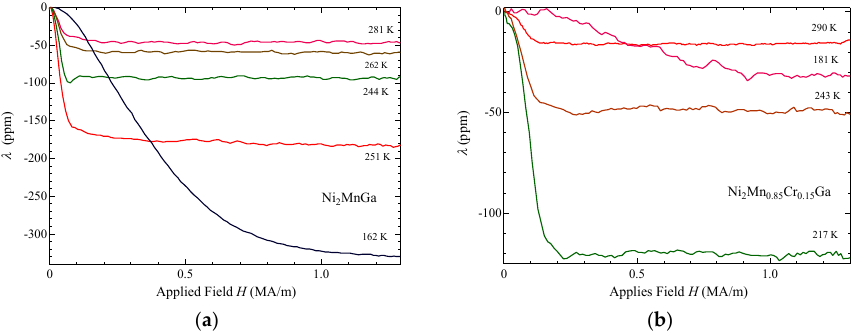
Figure 5. The magnetostriction λ for the ( a ) x = 0.00 alloy; and ( b ) x = 0.15 alloy, measured during cooling. The horizontal axis shows the applied magnetic field H .